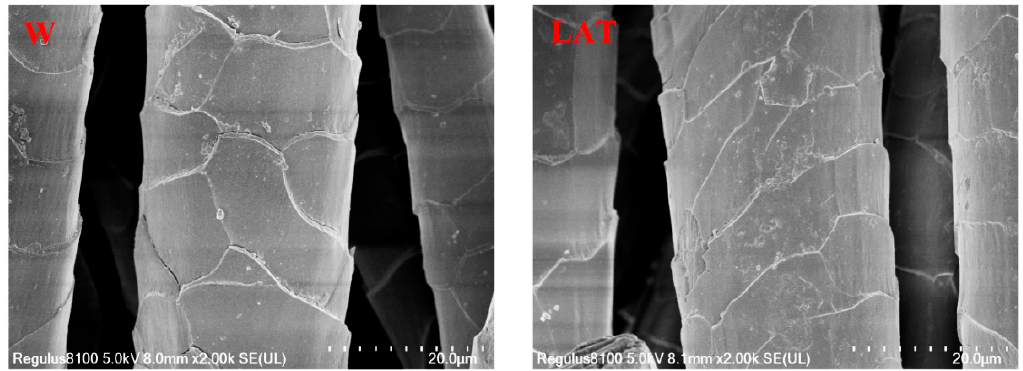
Figure 4. SEM ( × 2000) photos of wool fiber.